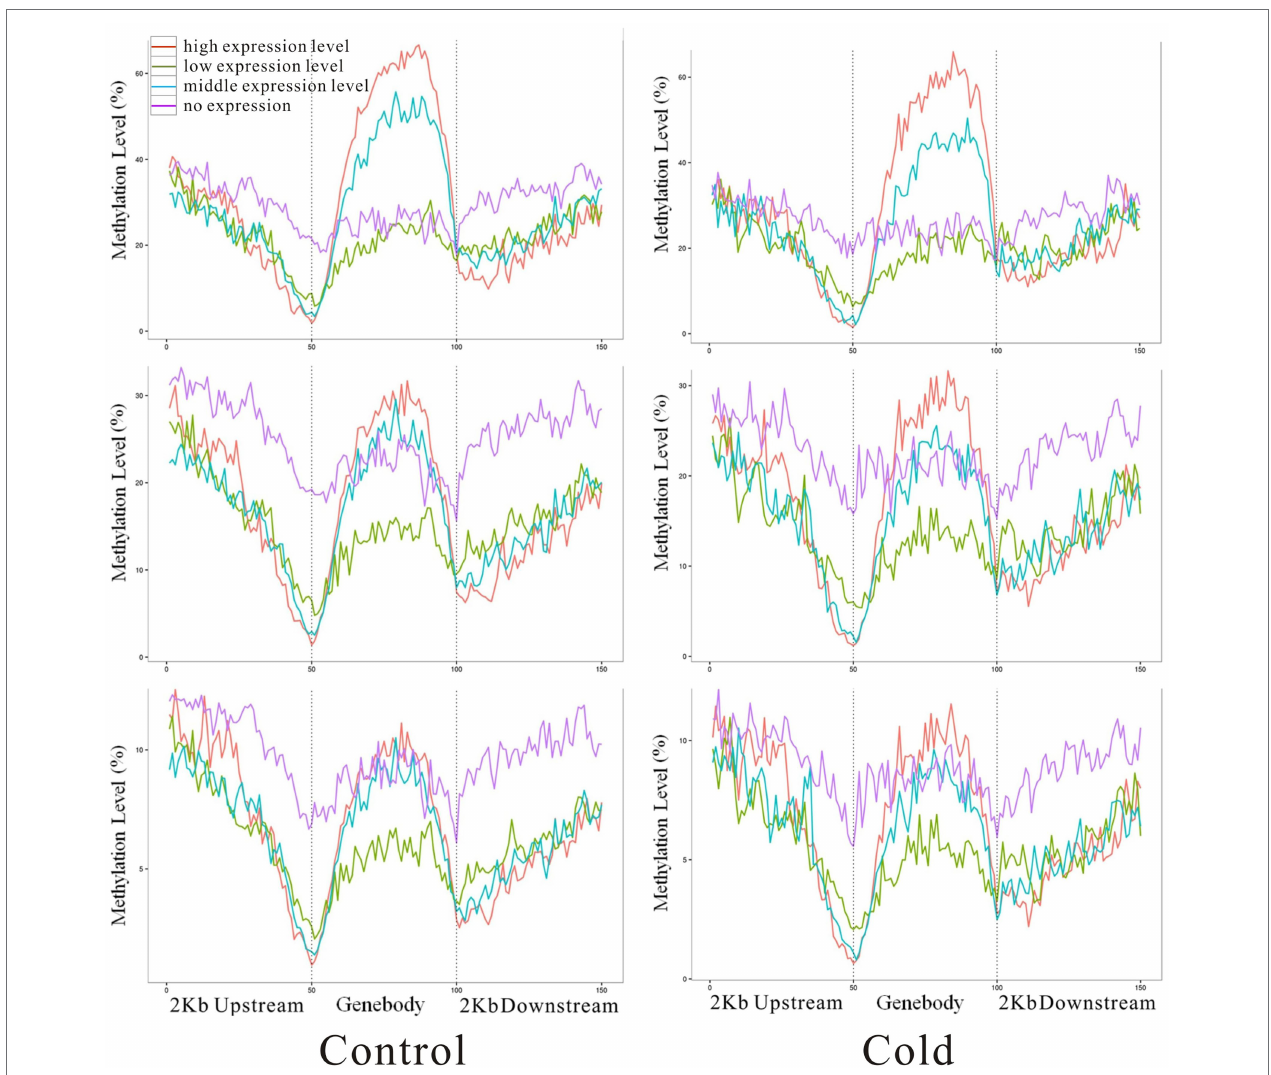
FIGURE 6 | Correlation of methylated cytosines with gene expression levels. The methylation level is indicated on the y -axis, and x -axis indicates the regions of 2 kb up and downstream of genebody. Red, green, blue, and pink colors represent high, moderate, low, and no expression of genes,